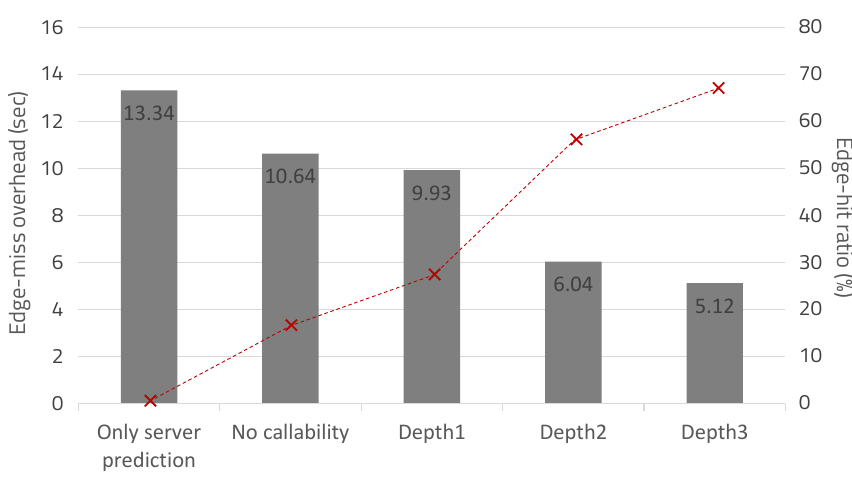
Figure 18. Overhead due to edge-miss according to the situation and edge-hit ratio.